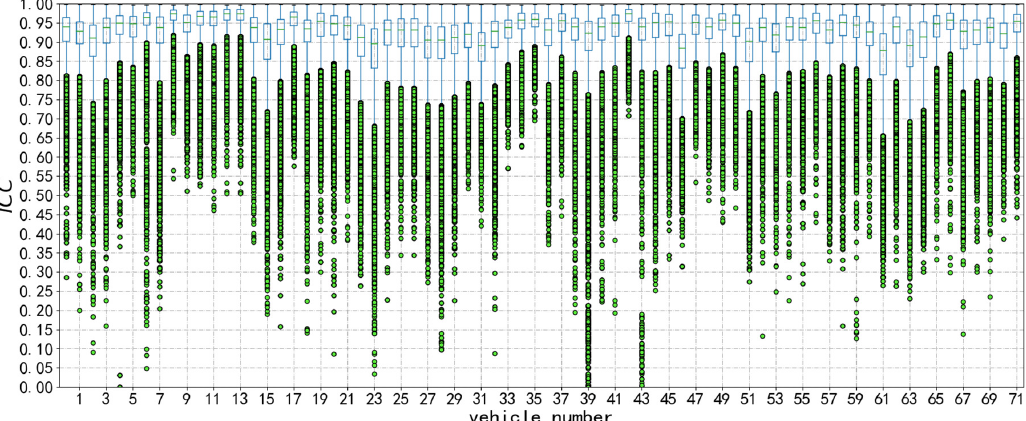
8 of 18 Figure 4. Graphs of the voltage of single batteries over time. 3.2.2. Threshold Calculation of Sub-Health State Type I Usually, the ICC ranges from 0.75 to 1. When the ICC < 0.75, it is considered that the two groups of data are inconsistent; on the contrary, when the ICC > 0.75, it is consid- ered that the two groups of data are consistent. Due to the consistency of the time series